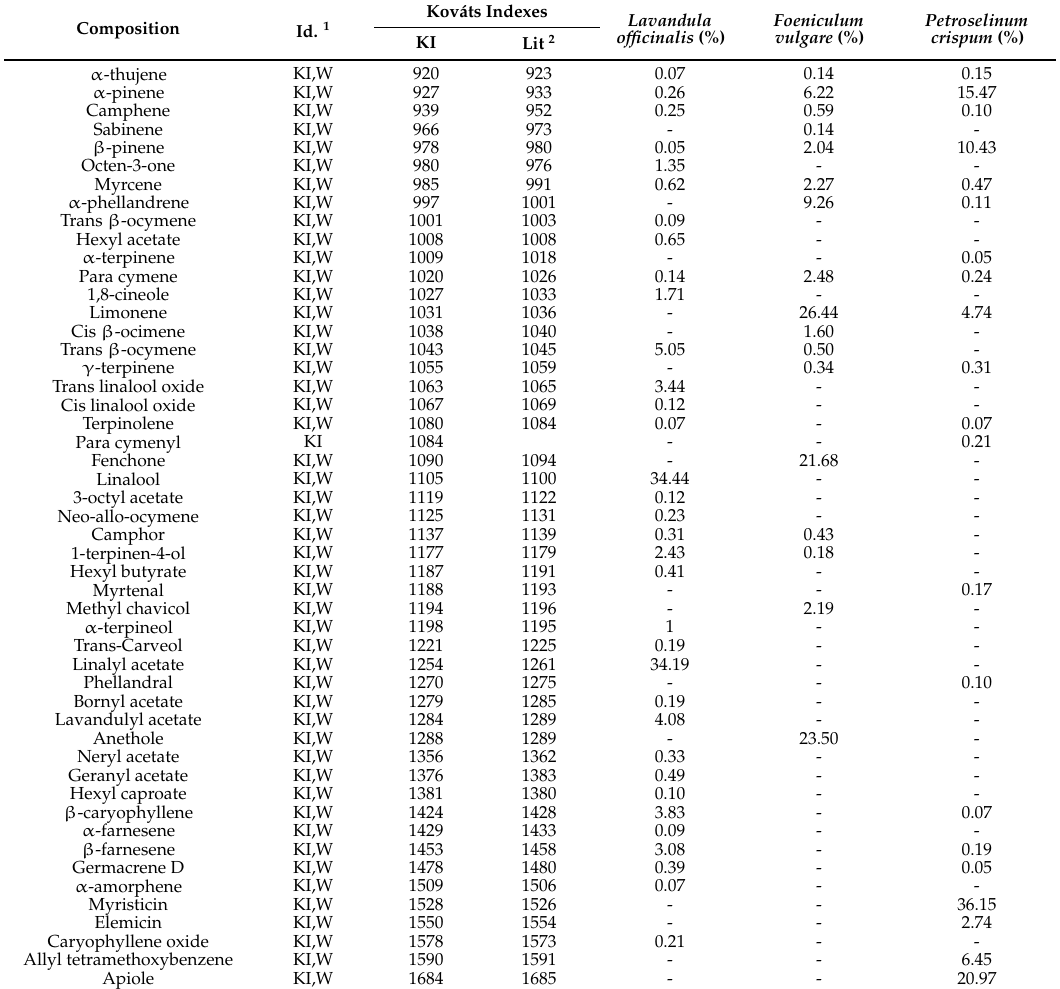
Table 1. Principal constituents of organic lavender, fennel, and parsley essential oils from Spain and their relative percentages of total chromatogram area, and Kovats Index. Composition Id.